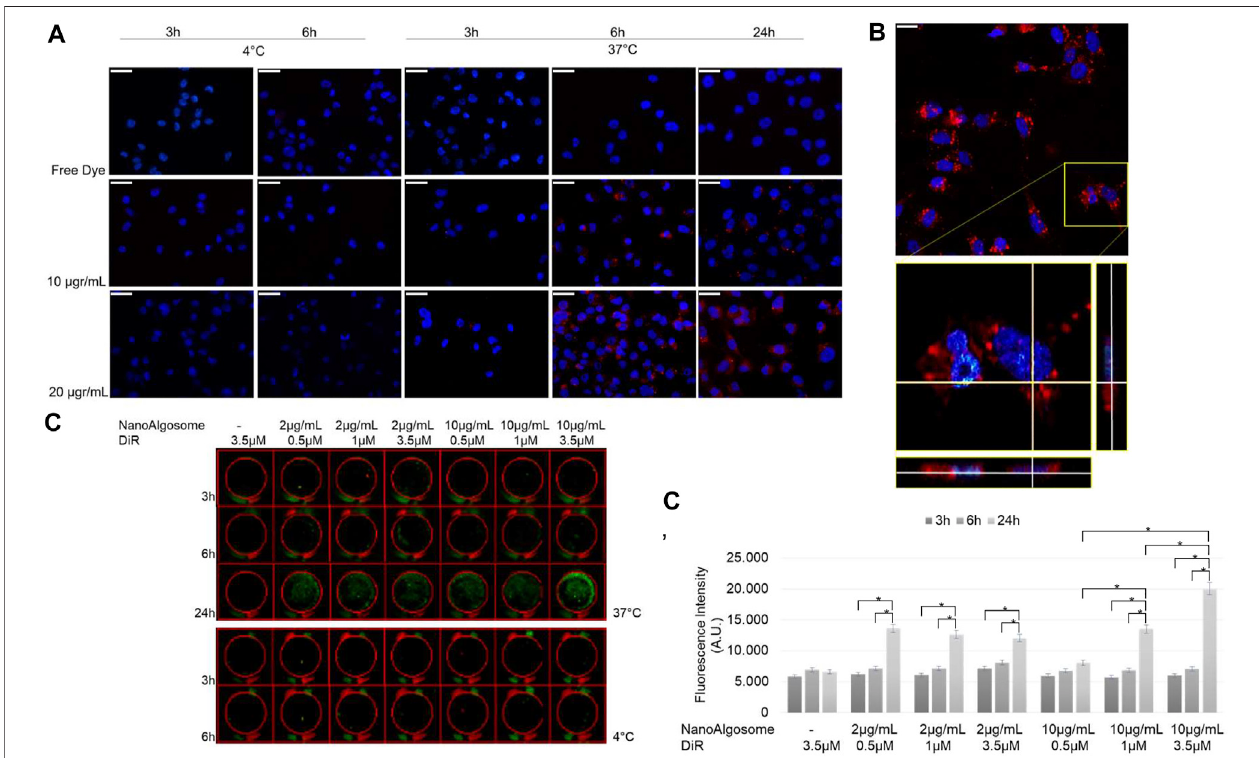
FIGURE 3 | Nanoalgosome cellular uptake in vitro . (A) Representative fl uorescence microscopy images showing the cellular uptake of PKH26- fl uorescent nanoalgosomes (red) in MDA-MB 231 cells (nuclei in blue) incubated with different concentrations of PKH26-labelled nanoalgosomes (10 and 20 μ g/ml) at 37 ° C for 3, 6 and 24 h. The free dye control and 4 ° C incubations are shown as negative controls (Magni fi cation 40X). Scale bar 50 µm. (B) Confocal microscopy analysis of PKH26-labelled nanoalgosome internalisation in MDA-MB 231 cells (nuclei in blue) incubated with 20 μ g/ml of red fl uorescent nanoalgosomes at 37 ° C for 24 h. The inset of confocal Z-stack acquisition shows its orthogonal projections at a focal depth of 9 μ m over a total scanning thickness of ~18 μ m (Magni fi cation 60X). Scale bar 25 µm. (C) Representative infra-red scanner images showing the cellular uptake of DiR-labelled nanoalgosomes (green) in MDA-MB 231 cells incubated with different concentrations of DiR-labelled nanoalgosomes at 37 ° C for 3, 6 and 24 h. The corresponding IR fl uorescence intensities are measured in triplicate (* p < 0.0001) and reported (C ’ ) through the in-cell function of Odyssey V3.0 software. Free dye and 4 ° C incubations are shown as negative controls.